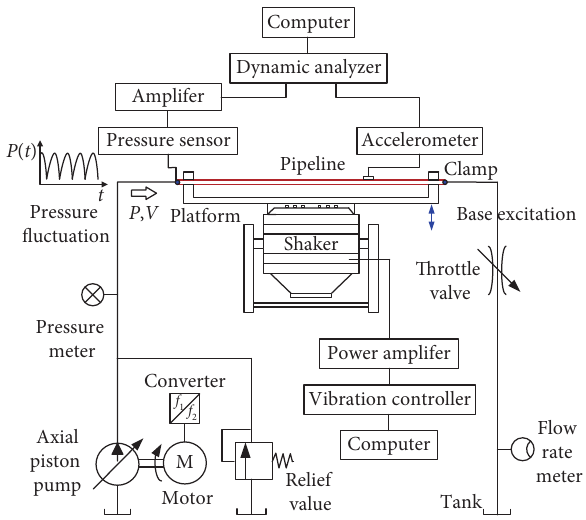
Figure 1: Schematic diagram of experimental